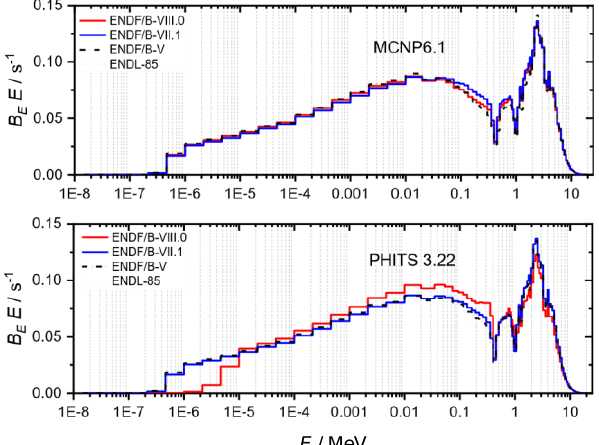
Fig. 2. A comparison of neutron spectra of the D 2 O- 252 Cf source assembly at 100 cm distance in vacuum for different released cross section data libraries, using the MCNP6.1 and PHITS3.22